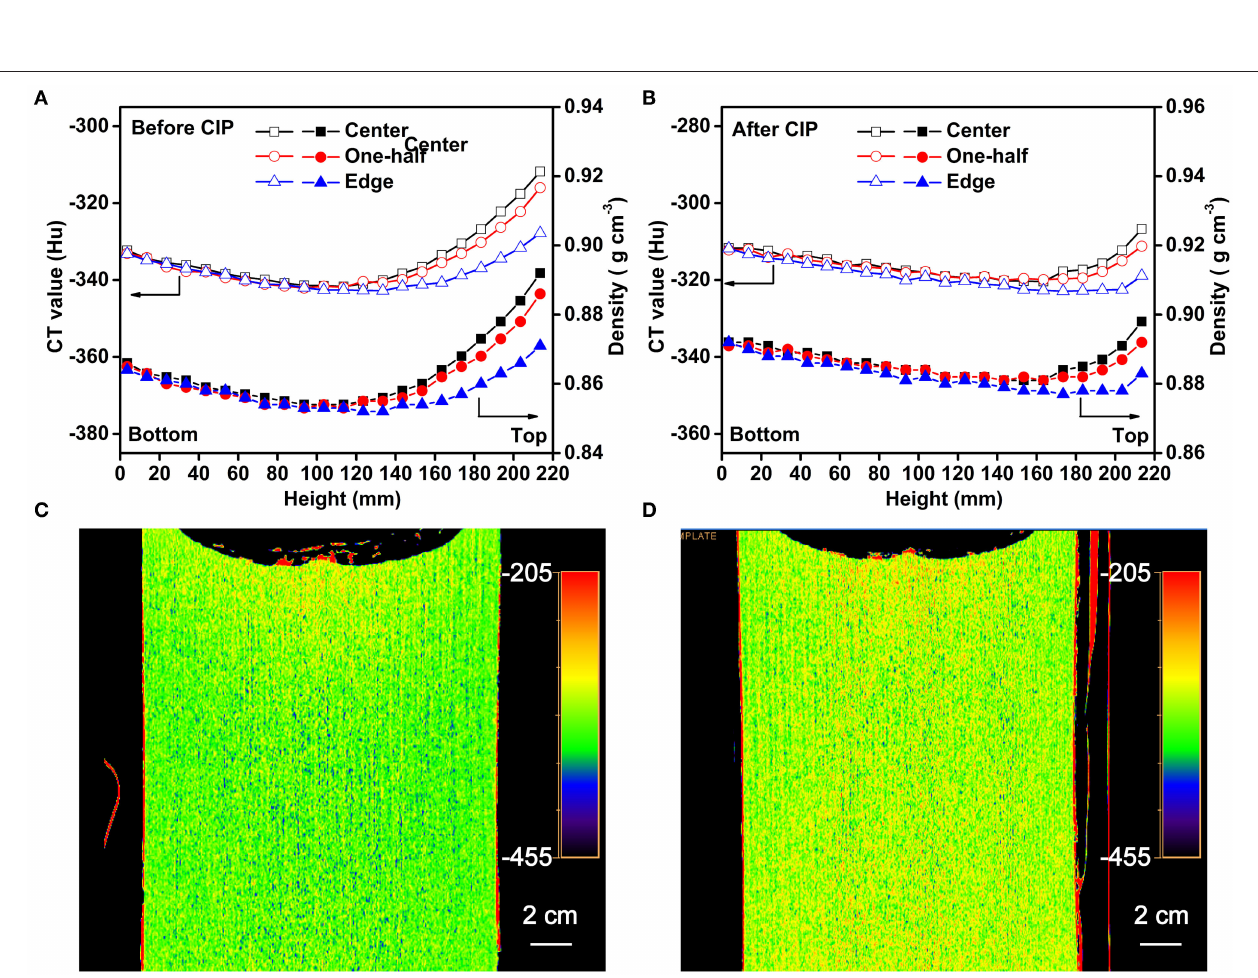
FIGURE 7 | The CT values and corresponding densities of the Li-B alloy ingot (A) before CIP and (B) after CIP. The CT image (C) before CIP and (D) after CIP.